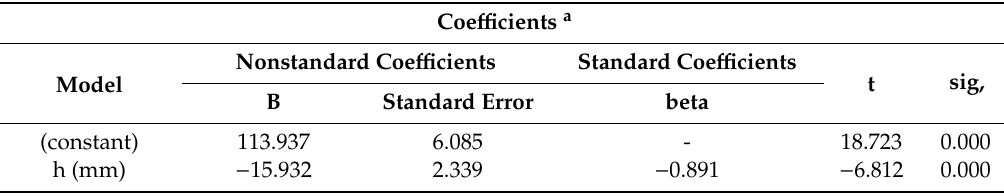
Table 10. Linear regression coe ffi cients for wheel-track test and first modulus of PLT ( Φ 600mm) at crown.